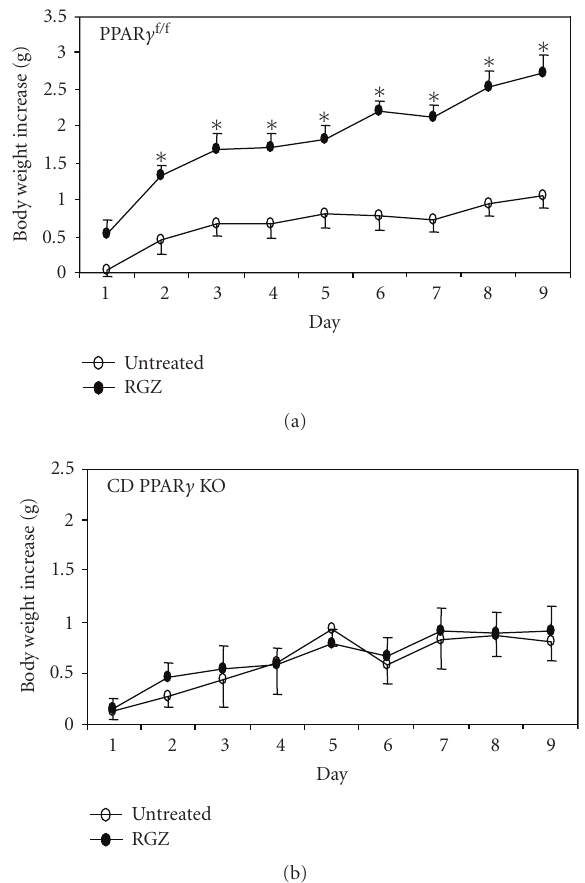
Figure 1: Body weight gains in untreated and rosiglitazone (RGZ)- treated PPAR γ f / f mice (a) and CD PPAR γ knockout mice (b) (adapted from [28]). ∗ , P < . 05 versus vehicle at the corresponding time